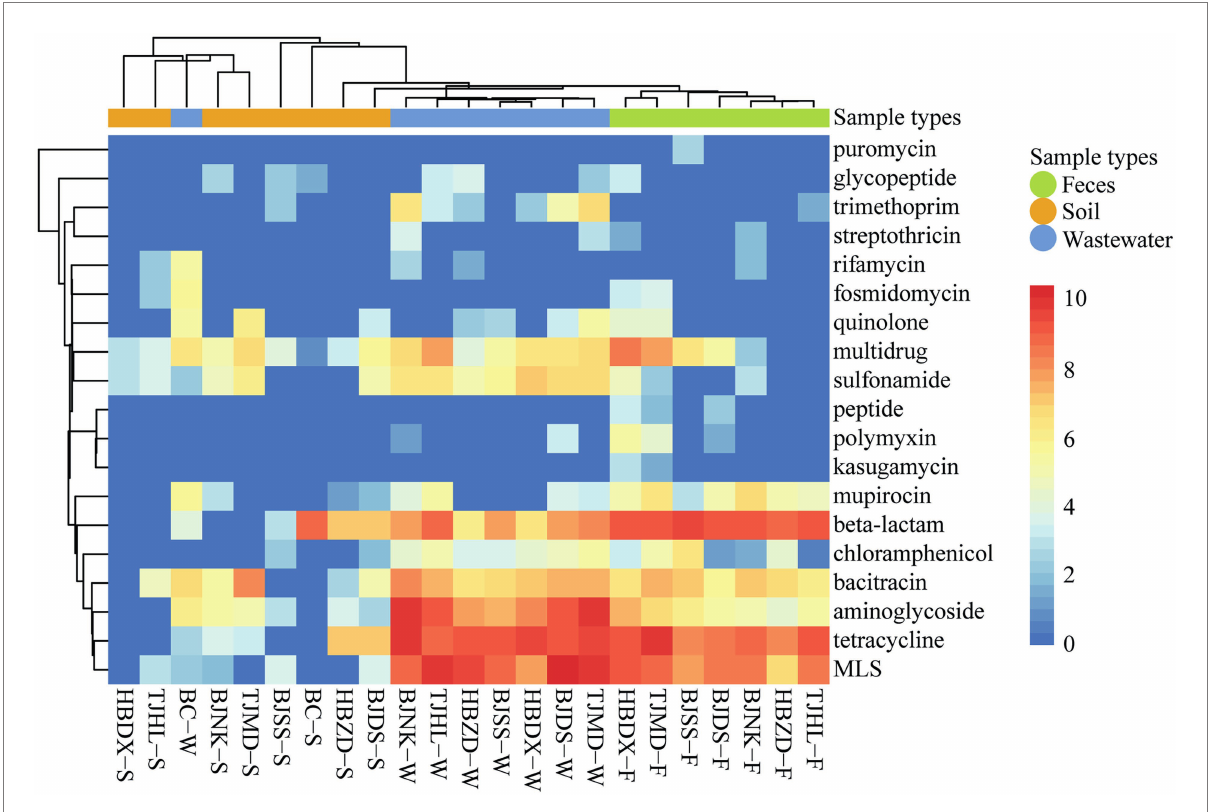
FIGURE 1 Heatmap of ARG types (coverage, × /Gb, log2 transferred) in 23 environmental samples. The combination of four letters (e.g., TJHL) represents a farm; BC, blank control; W, wastewater; F, feces; S,